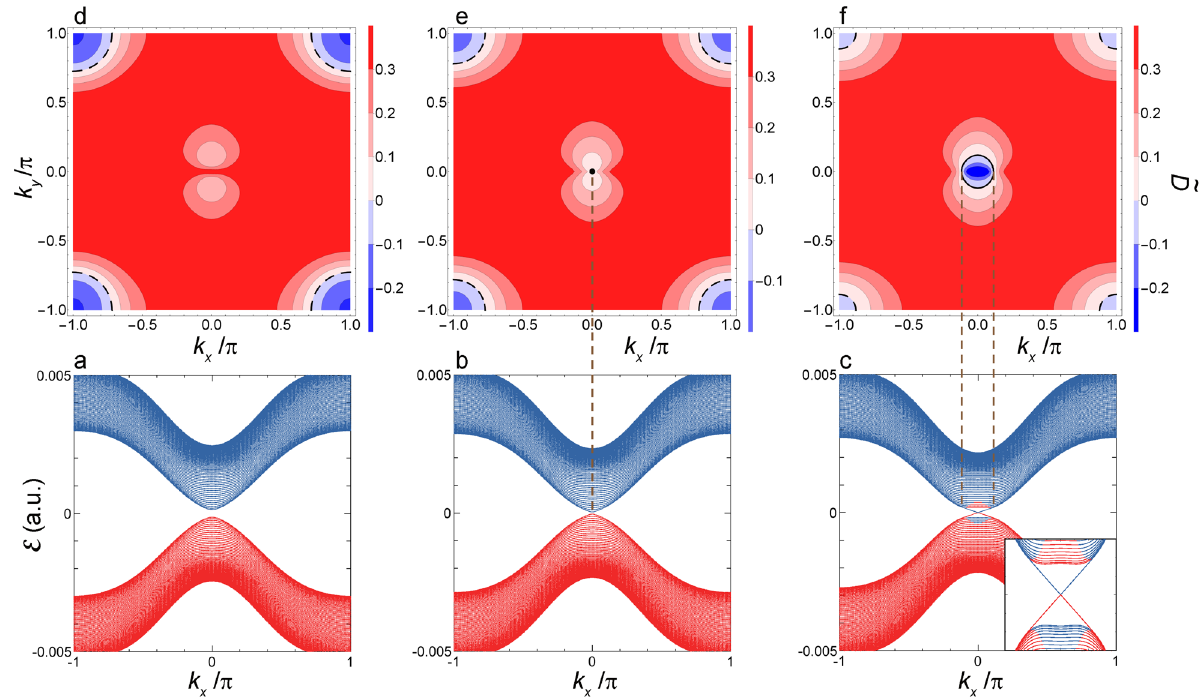
Figure 4. Quasienergy dispersion of E ( k x ) and interband polarization ˜ D ( k ) in the vicinity of F Ŵ x . ( a ) Shown are E p ( 1 ) ( k x ) and E s ( − 1 ) ( k x ) as functions of k x at F x = 3.82 × 10 − 4 ( 1.96MV/cm ) ( F x > F Ŵ x ) . The two quasienergy bands p (1) and s ( − 1 ) are shown by red and blue lines, respectively. ( b ) The same as the ( a ) but at F Ŵ x = 3.73 × 10 − 4 ( 1.92MV/cm ) . ( c ) The same as the ( a ) but at ) . Inset: the expanded view of these two bands in the vicinity < F x < F Ŵ F x = 3.62 × 10 − 4 ( 1.86MV/cm ) ( F X 2 x x of the ¯ Ŵ -point. ( d ) Shown is a contour map ˜ D ( k ) in the ( k x , k y ) -plane at F x given by ( a ). Contours indicating the boundary of ˜ D ( k ) = 0 are shown by black dashed lines. ( e ) The same as the ( d ) but at F Ŵ x . Besides, a pinhole indicating ˜ D ( k ) = 0 at the Ŵ -point is shown by a black filled circle. The vertical dashed line shows the projection of ˜ D ( k ) = 0 (the pinhole) onto the k x -axis shown in the ( b ). ( f ) The same as the ( d ) but at F x given by ( c ). Contours indicating the boundary of ˜ D ( k ) = 0 are shown by black solid and dashed lines. The vertical dashed lines show the projection of ˜ D ( k ) = 0 (the zero contour) onto the k x -axis shown in the ( c